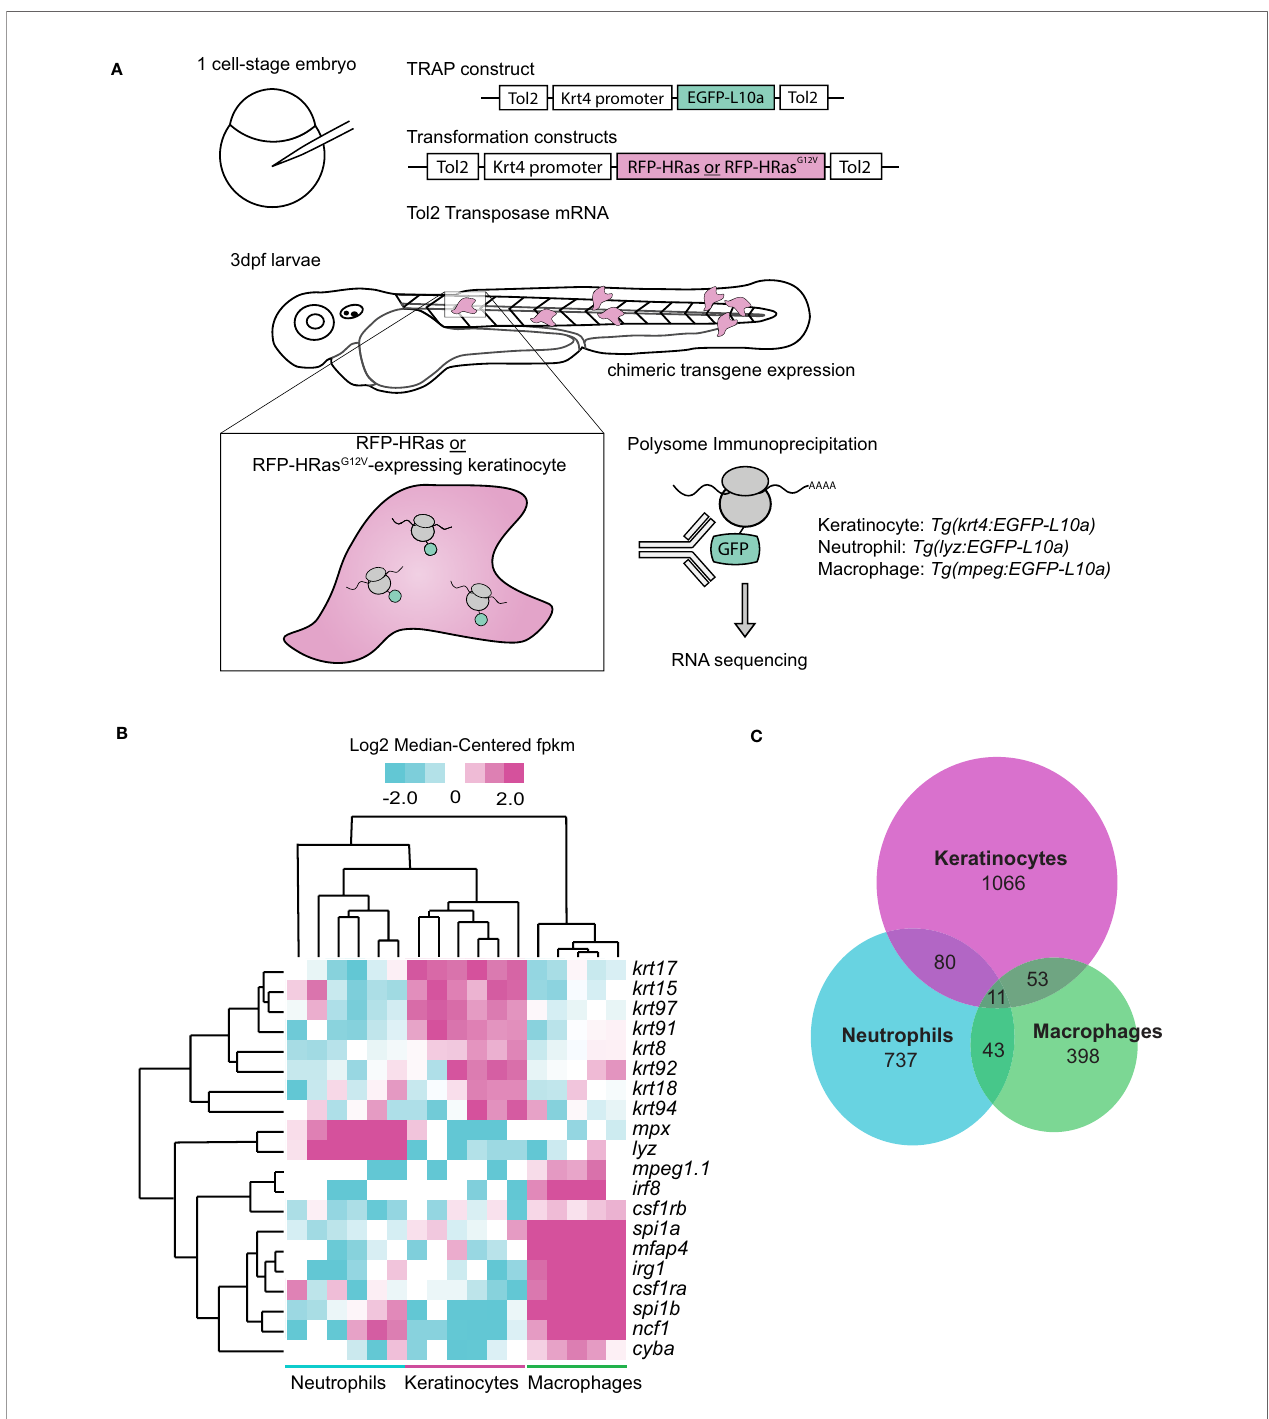
FIGURE 1 | Oncogenic HRas induces differentially expressed genes in neutrophils and transformed cells in zebra fi sh larvae. (A) Schematic of Translating Ribosomal Af fi nity Puri fi cation (TRAP) procedure. Wild-type embryos were injected with the TRAP plasmid (pTol2-Krt4-EGFP-L10a) and either control (pTol2-Krt4-HRas-mcherry) or oncogenic transformation (pTol2-Krt4-HRas G12V -mcherry) constructs. Immunoprecipitation and sequencing were conducted 3dpf on batches of ~50 larvae collected on three separate days (n=3). Tg(LyzC : EGFP-L10a) or Tg(mpeg:EGFP-L10a) larvae were injected with either control (pTol2-Krt4-HRas-mcherry) or oncogenic Ras (pTol2-Krt4-HRas G12V -mcherry) constructs for neutrophil- or macrophage-targeted L10a expression, respectively. (B) Cell type speci fi c genes expressed in keratinocytes ( krt17, krt15, krt97, krt91, krt8, krt92, krt18 , krt94), neutrophils ( mpx,lyz ), or macrophages ( mpeg1.1, irf8, csf1rb, spi1a, mfap4, irg1, csf1ra, spi1b, ncf1, cyba ) and their expression pro fi les in TRAP samples from keratinocytes, neutrophils, and macrophages. (C) Venn diagram showing distribution of genes altered >2fold by TRAP-seq in response to HRas G12V expressing keratinocytes